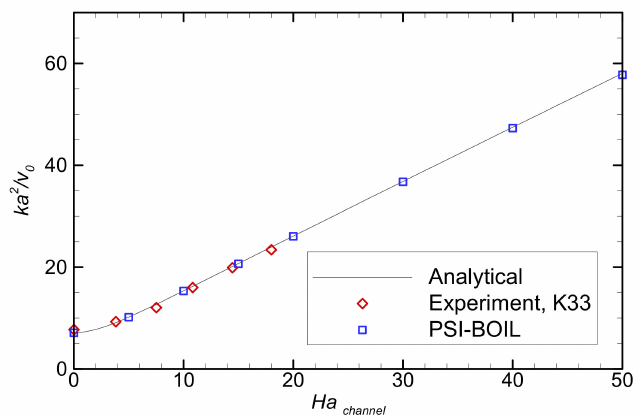
Figure 5. Comparisons of the inverse of the non-dimensionalized mean velocity ka 2 / v 0 between the analytical solution [38], the experiment [39] and our CFD simulations obtained using